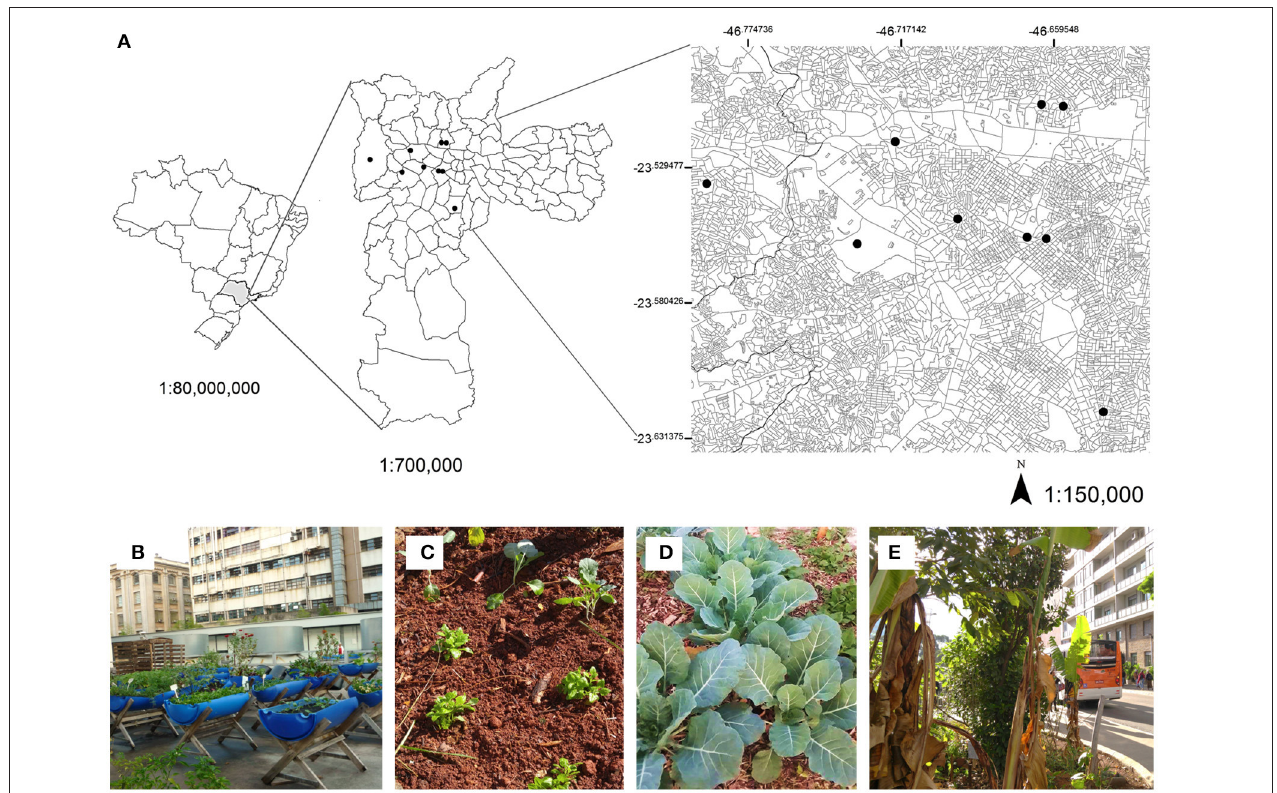
FIGURE 1 | (A) Locations of exposure and sampling in the municipalities of Sao Paulo and Osasco. (B) Experimental setting of controlled vessels in urban garden “F.” (C) Vegetable samples prior to exposure (D) Collard greens after 45 days of cultivation in a bed of soil (E) View of urban garden “G,” which is located close to an area with high traffic density and constant traffic jams. Garden identifiers are not publicly available to protect garden identity.